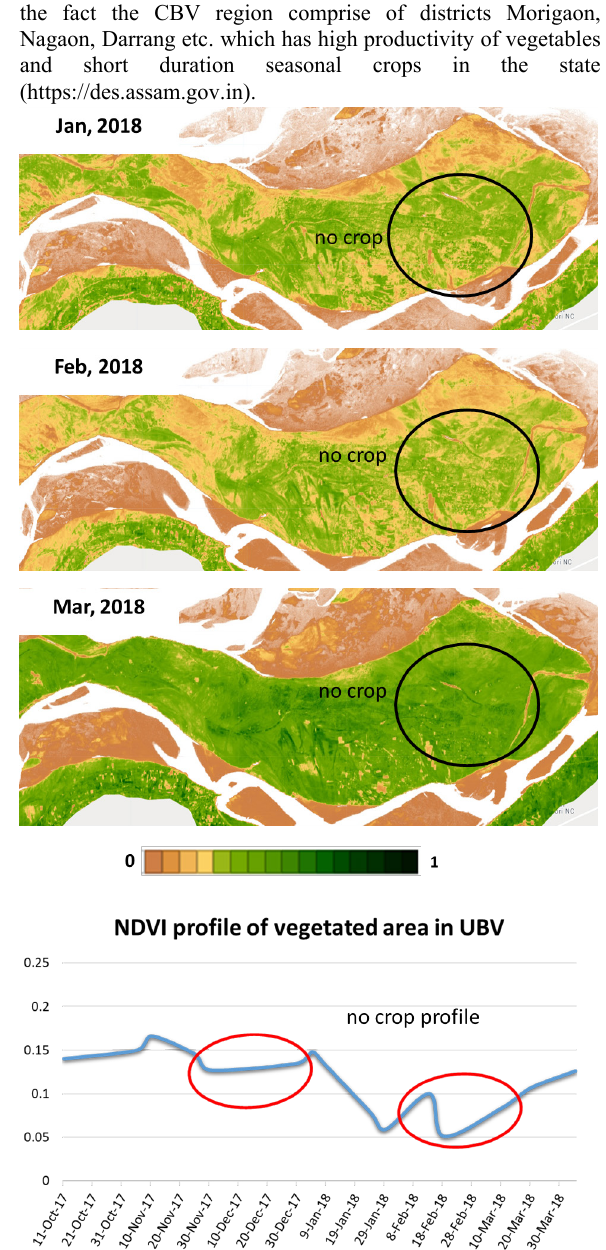
Figure 7. Change in NDVI profile showing fallow land/ no crop within the chars in UBV as seen from Sentinel-2